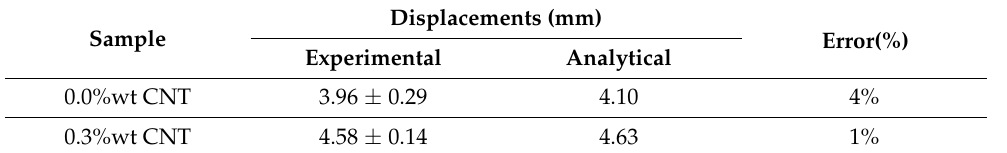
Table 5. Results of the